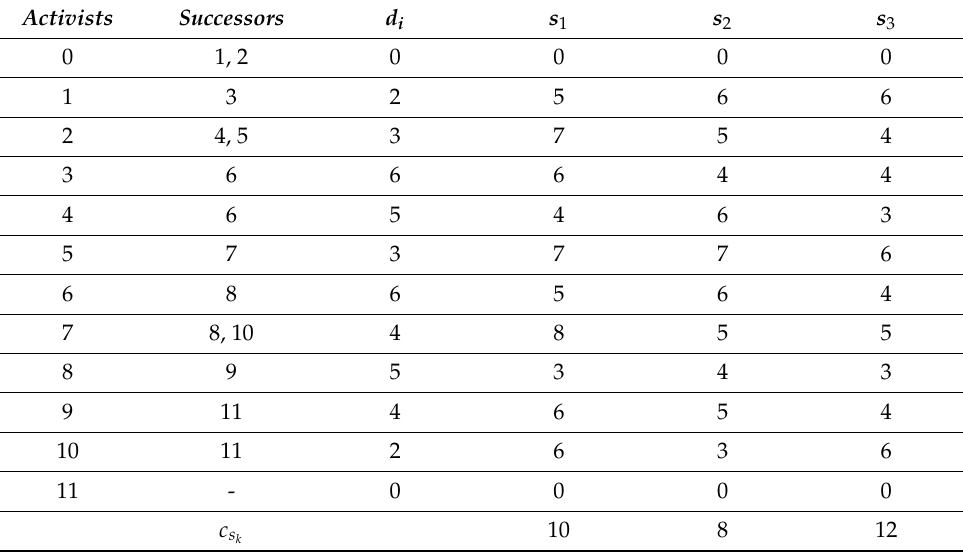
Figure 2. Project Network Example. Table 2. Project information.